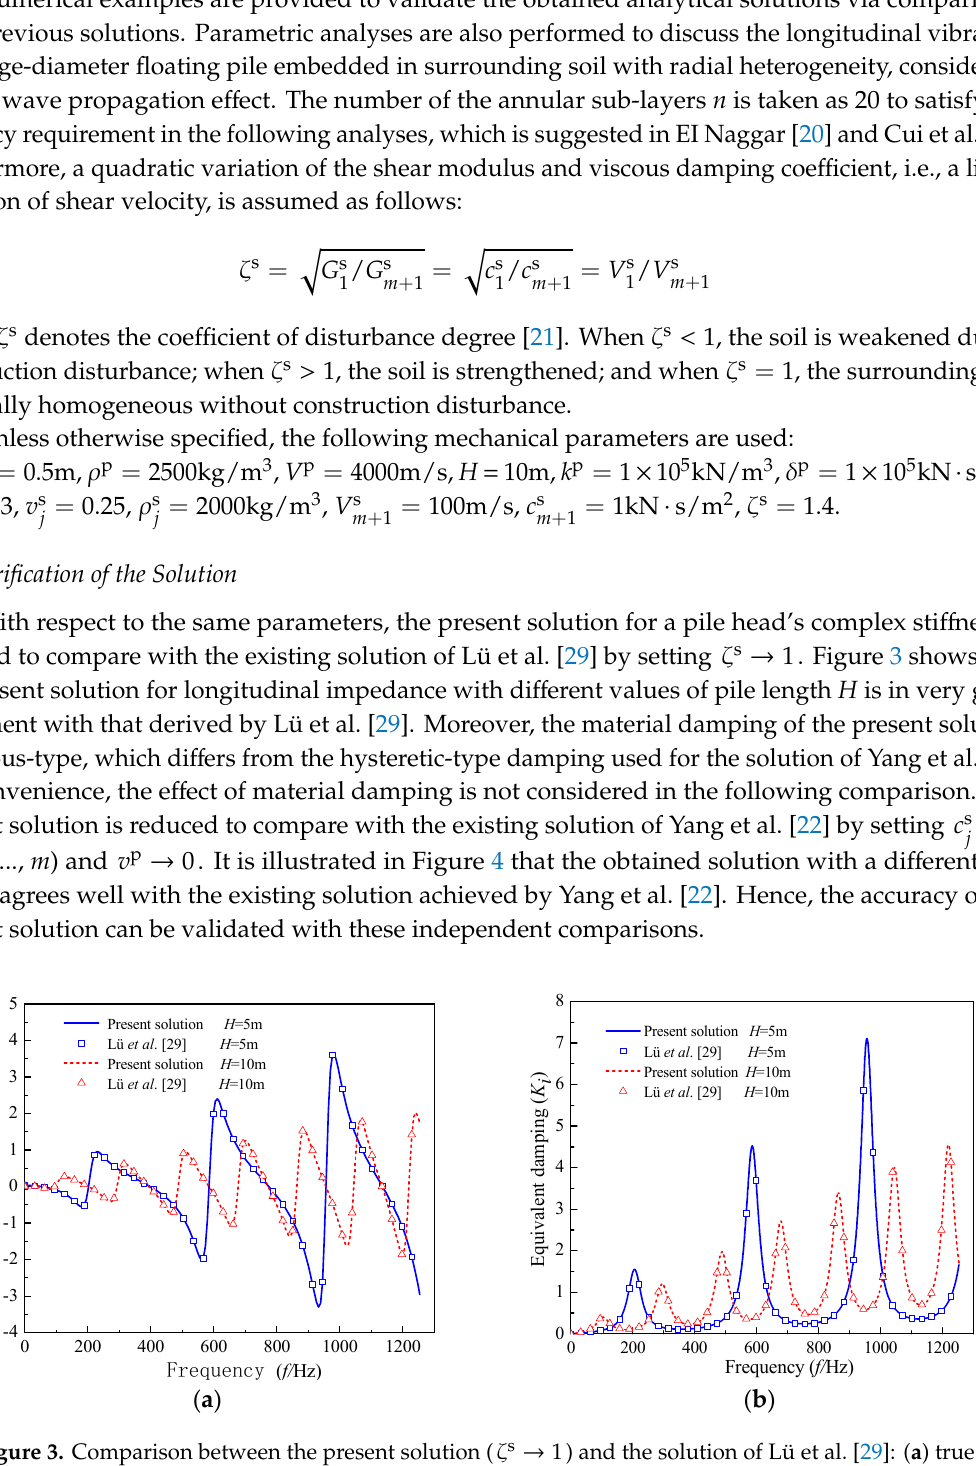
Figure 3. Comparison between the present solution ( ζ s → 1) and the solution of Lü et al. [29]: ( a ) true stiffness; ( b ) equivalent damping.